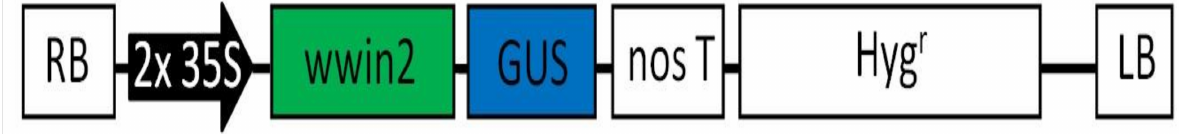
Figure 1. Schematic map of the pMDC140 T-DNA region after the integration of the wwin2 gene. RB: right border; 2 × 35S: 35S promoter region of cauliflower mosaic virus; wwin2 : wheatwin2 pathogenesis-related 4 gene; GUS : β -glucuronidase reporter, nos T : nopaline synthase terminator; Hyg r : hygromycin resistant gene; LB: left